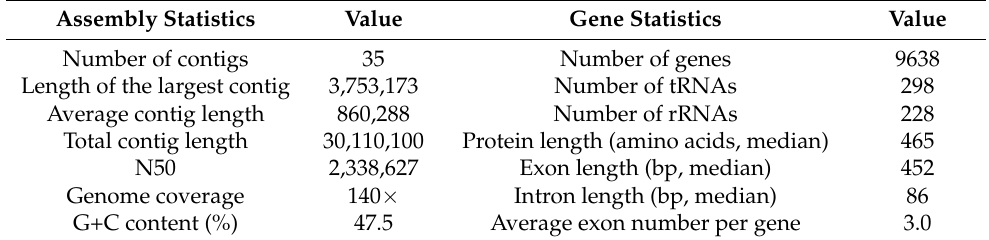
Table 1. Genome assembly statistics for A. resinae KUC3009.